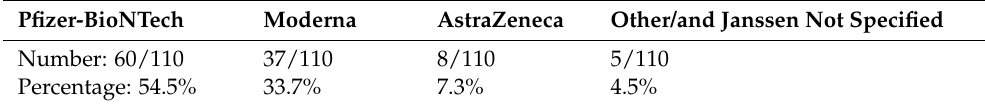
Table 1. Type of vaccine and occurrence of myocarditis and/or pericarditis in the reported case series. Pfizer-BioNTech Moderna